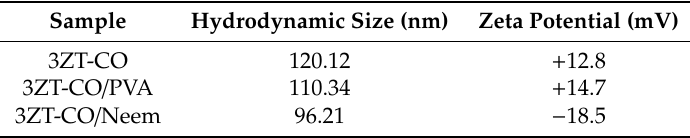
Table 1. The zeta potential and hydrodynamic size of the samples at pH 7.